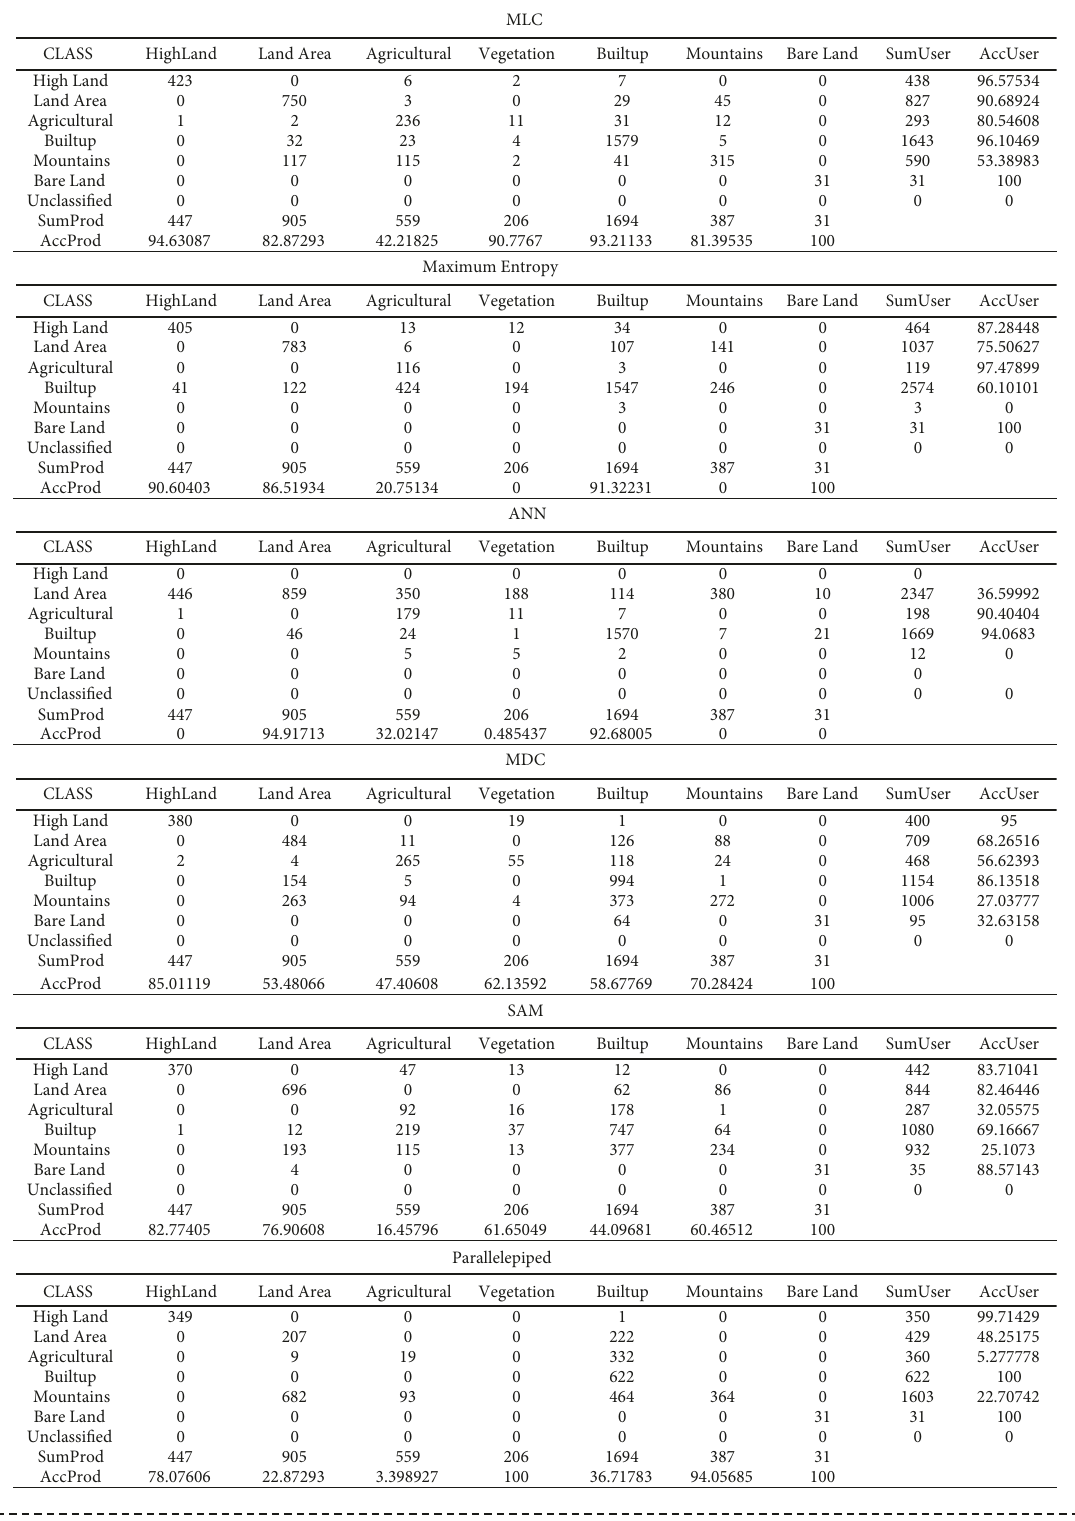
Figure 8: Group 2 confusion matrix tables for machine learning methods of Sentinel-2A